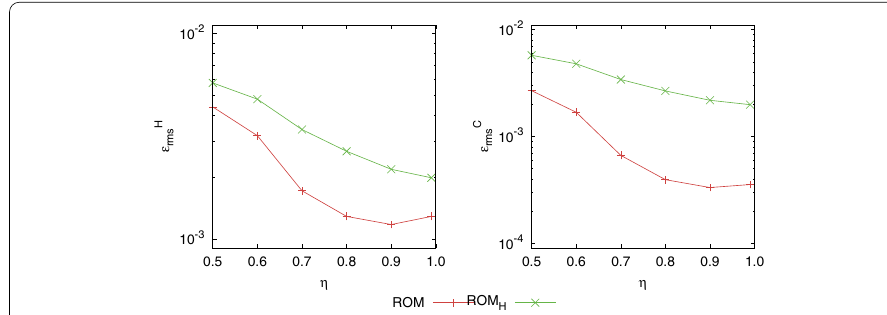
Fig. 15 (cid:14) rms convergence. Hot wall (cid:14) H rms and cold wall (cid:14) C rms